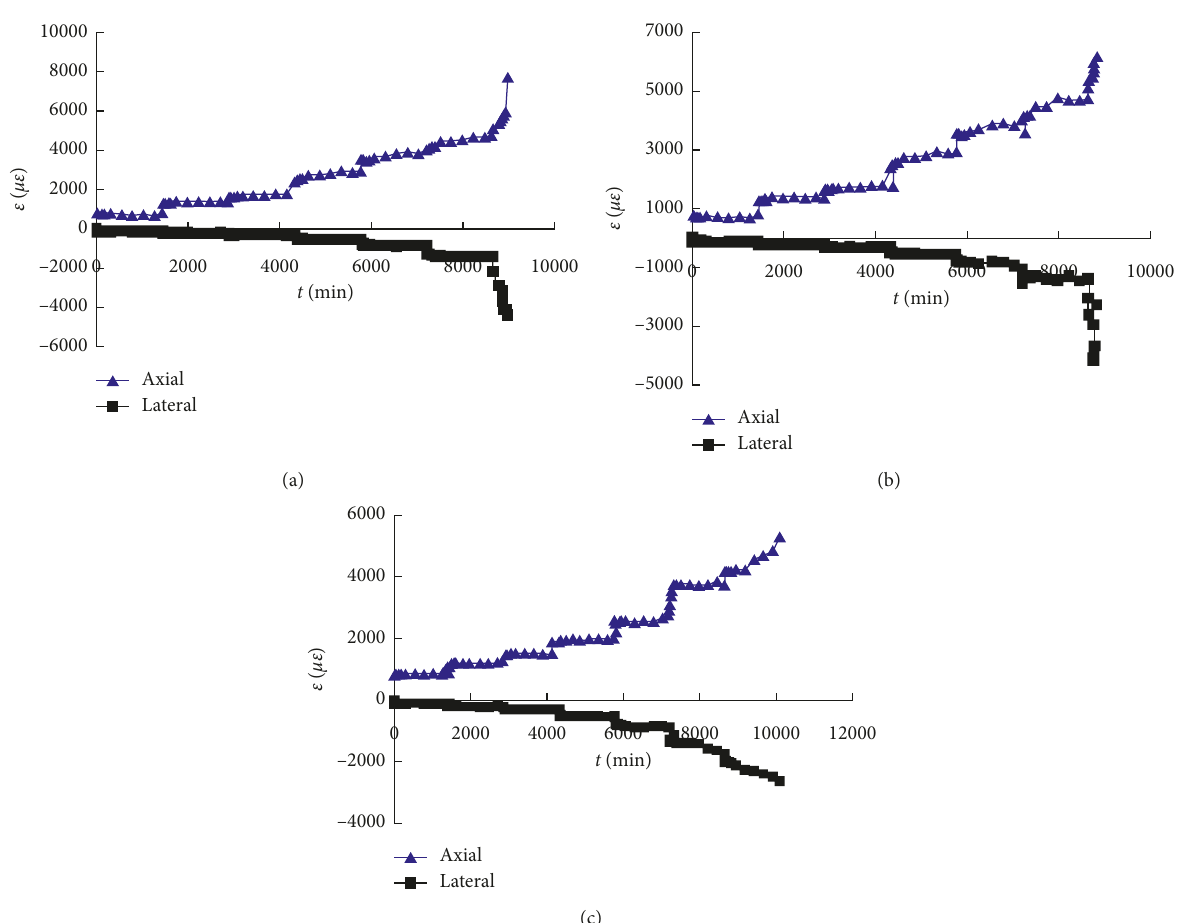
Figure 4: Axial and lateral creep curves under step loading: (a) Specimen 1; (b) Specimen 2; (c) Specimen 3.